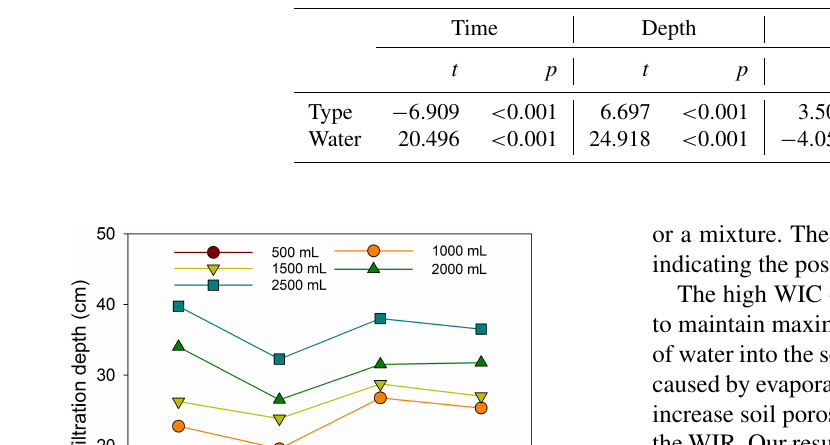
Table 2. The results of GLM analysis for effects of crust types and the amount of water supply on the water infiltration time, infiltration depth and infiltration rate in the study. Note: type – bare sandy land, moss crust, litter crust for 2 years, litter crust for 4 years; water supply – 500, 1000, 1500, 2000 and 2500mL.